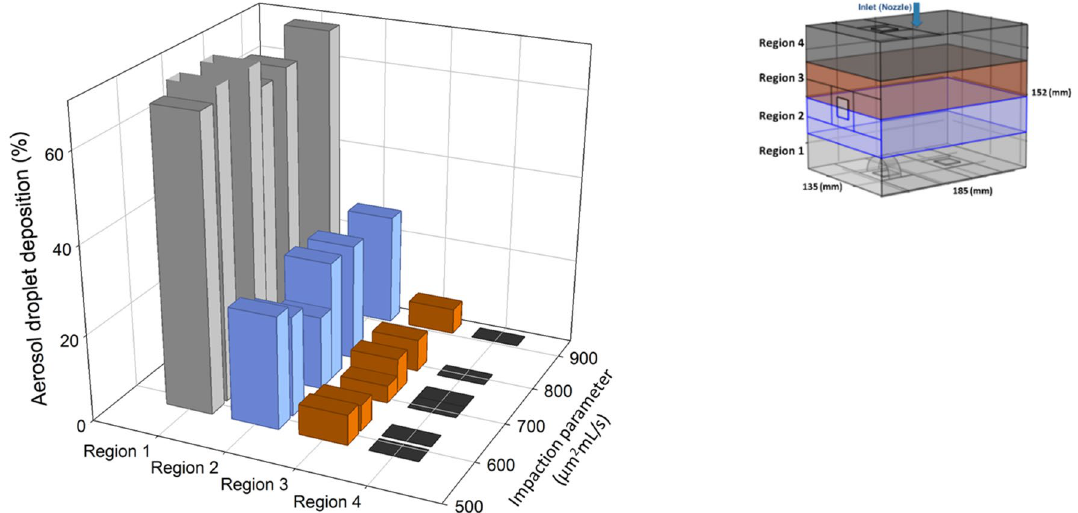
Figure 11. Comparison of the simulated aerosol droplets deposition in four regions of the CFD box model for different values of the impaction parameter. Each bar represents the deposition percentage of the aerosol droplets in the box